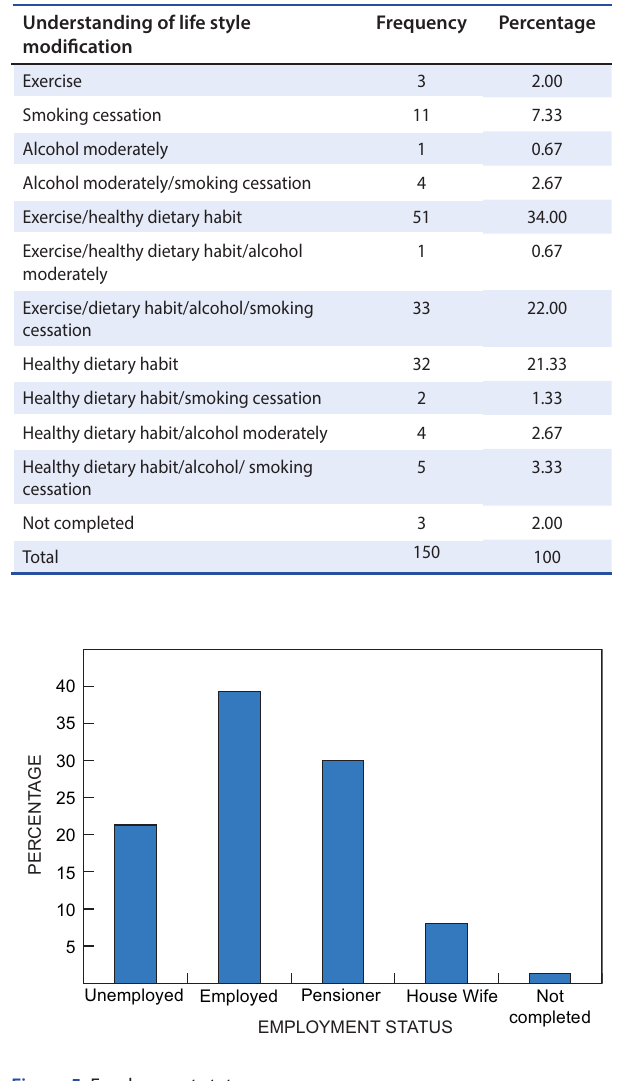
Figure 5: Employment status.